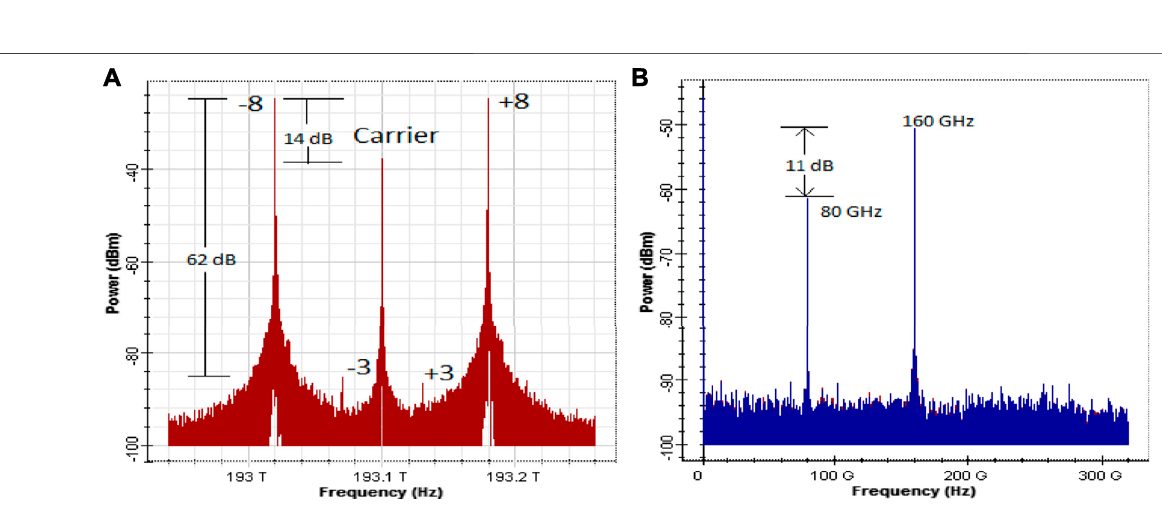
FIGURE 8 | (A) Optical spectrum and (B) RF spectrum output at M. I of 2.776.